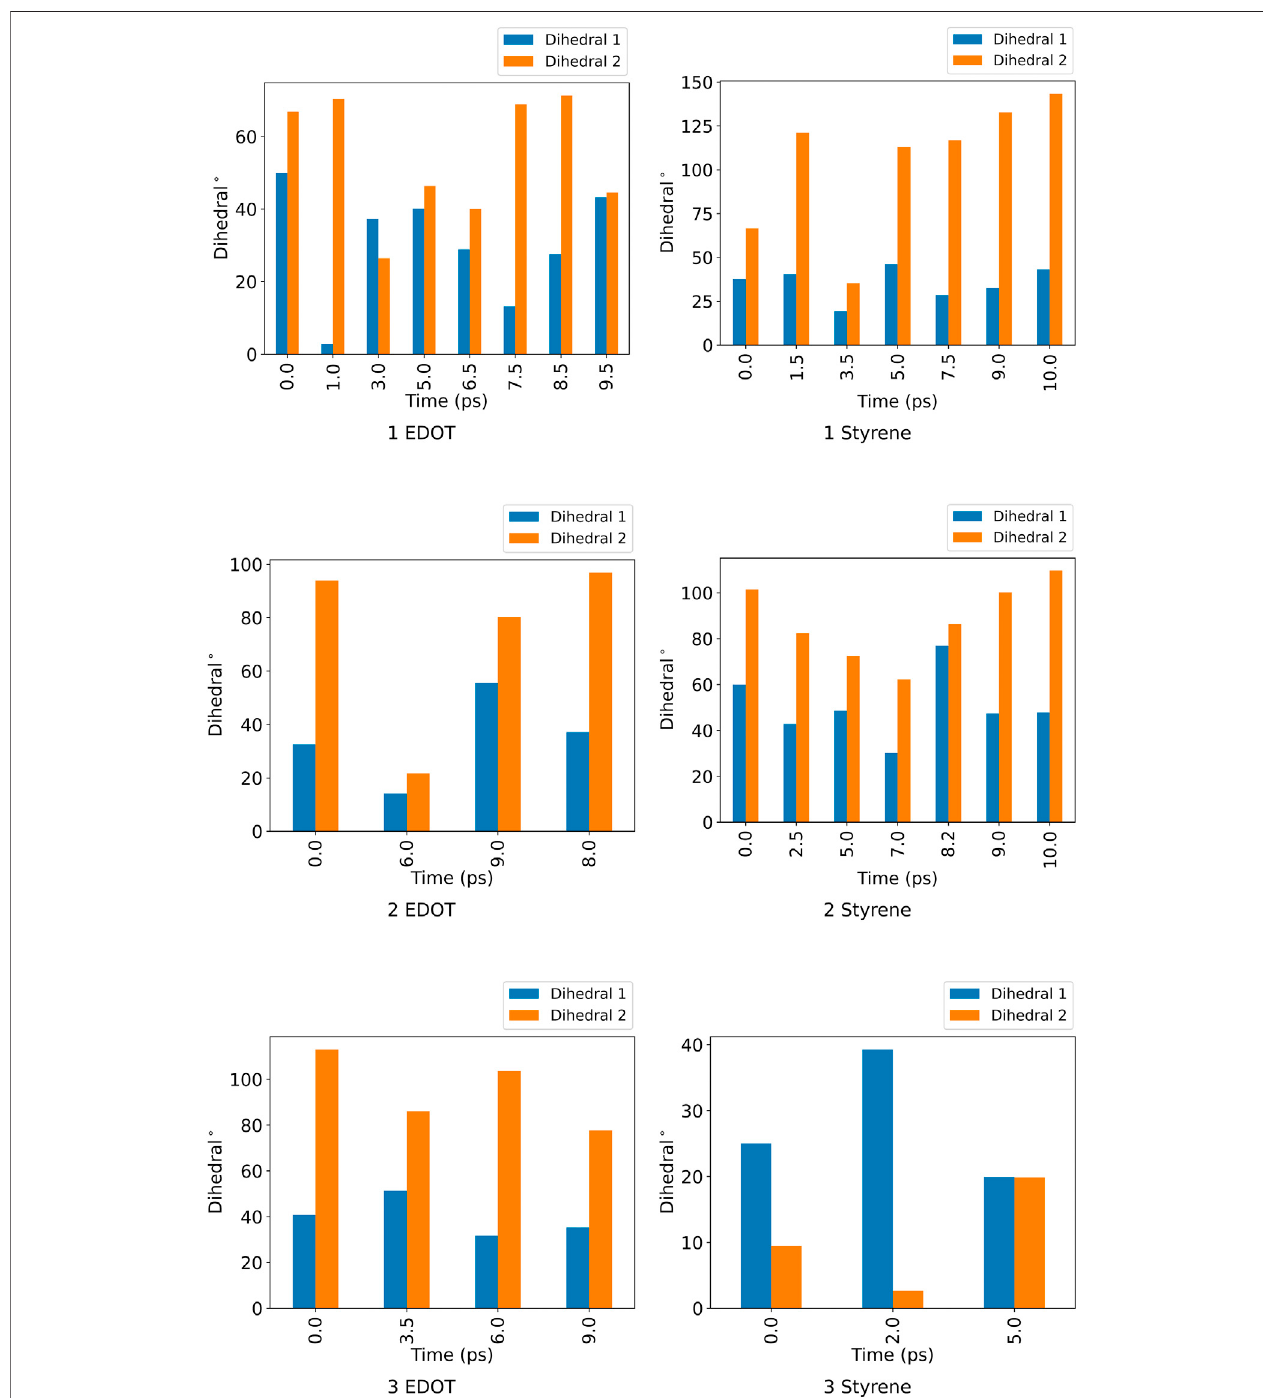
FIGURE 4 | Dihedral angles for the two pairs positionally distinct ndc linker in the unit cell for the distinct conformational states of ZnPW I EDOT and ZnPW I styrene motifs for nano-channel interaction.